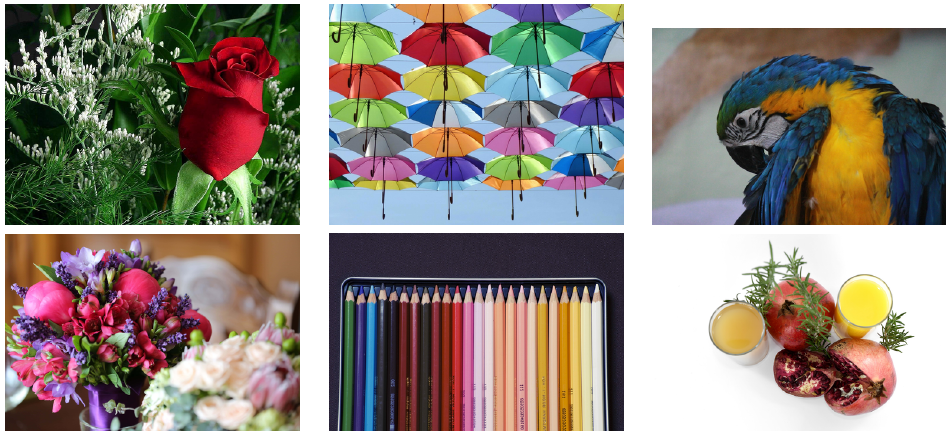
Figure 1. Test images from Pixnio. All images are available under the CC0 licence.